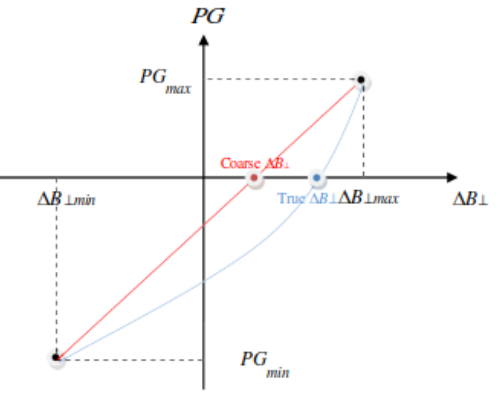
Figure 3. Schematic representation of the coarse estimation of ∆ B ⊥ . A similar procedure is followed for ∆ B (cid:107) .